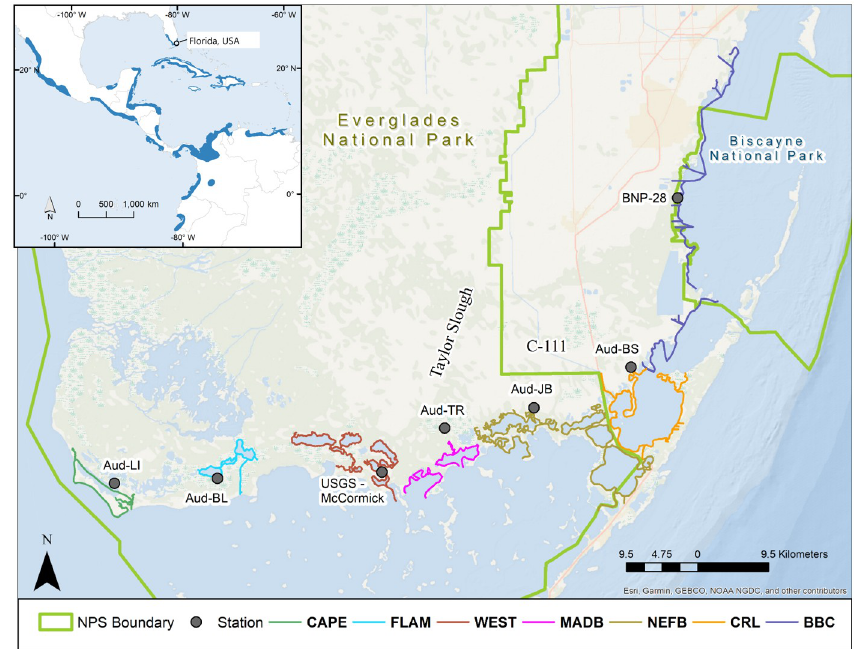
Fig 1. Study area of American crocodile ( Crocodylus acutus ) survey routes from Biscayne Bay Complex west to Cape Sable in South Florida, USA. Survey routes are grouped by areas: BBC = North and South Biscayne, and Card Sound; CRL = Crocodile Lake National Wildlife Refuge, North Key Largo, Barnes Sound, and Manatee Bay; NEFB = NE Florida Bay from US1 to Alligator Bay (including Long, Little Blackwater and Blackwater Sounds, Joe Bay, Davis Cove, Deer Key and Alligator Bay); MADB = Little Madeira Bay, Taylor River, and Madeira Bay; WEST = West, Cuthbert, Long, Seven Palm, Middle, and Monroe Lakes, and Terrapin Bay; FLAM = Flamingo, Buttonwood and Homestead canals, Coot Bay, Mud and Bear Lakes; CAPE = Cape Sable beaches, East Cape Canal, Lake Ingraham and associated creeks. Representative hydrological monitoring stations for each area are indicated with a black circle.